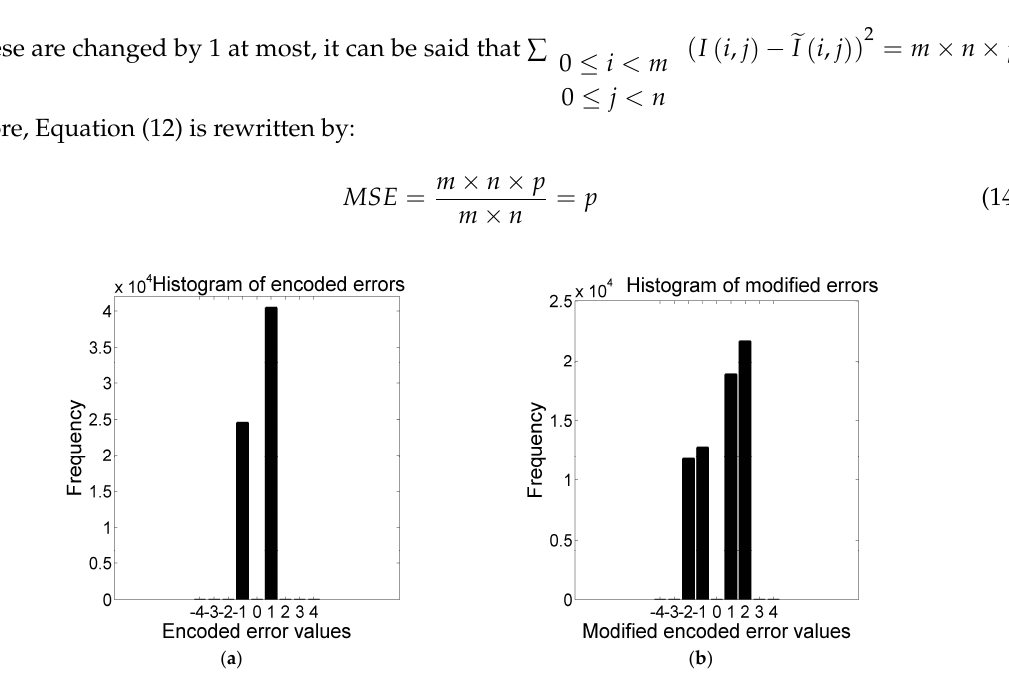
Figure 8. Histogram of ( a ) encoded error and ( b ) stego errors, which are generated by experimenting on the Lena image of size 255 × 255 pixels.